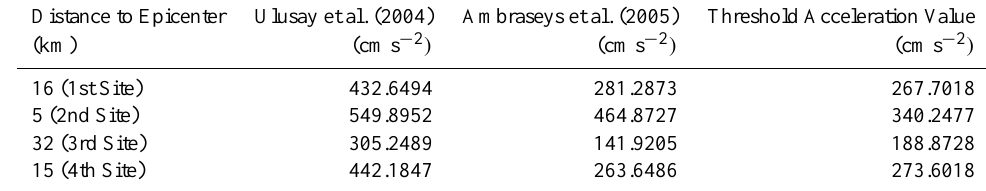
Table 1. Estimated peak ground accelerations for the given distances and threshold acceleration values in each